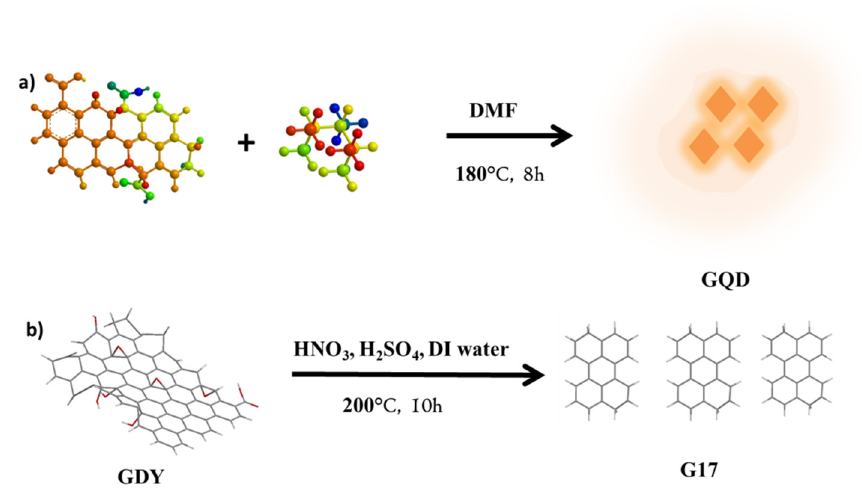
Figure 19. Schematic representation of the preparation of ( a ) GQD and ( b ) GDQD, Reprinted from [74] with permission from Elsevier.